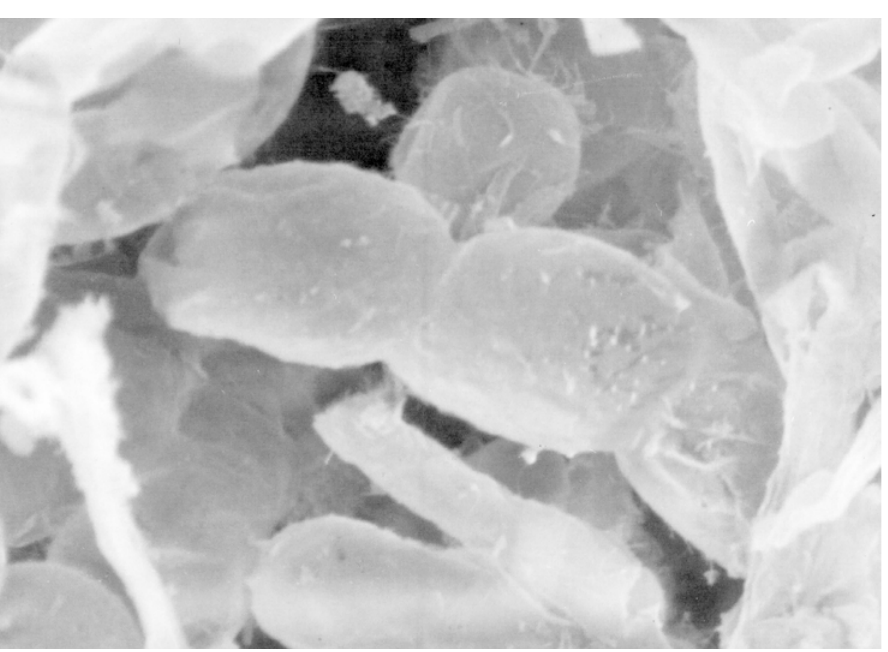
Fig. 5. Fragmentation of hyphae of Phoma septicidalis (SEM x 3000). Phot. M.